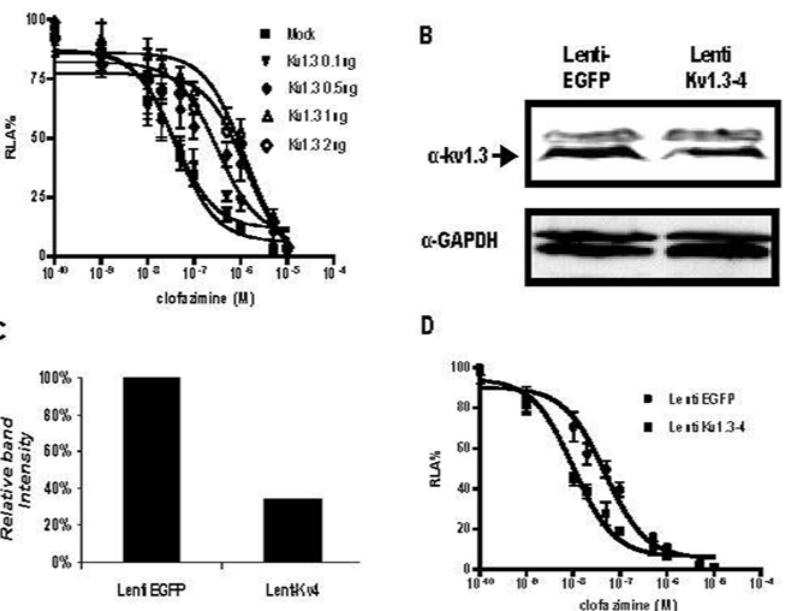
Figure 5. ( A ) Over-expression of Kv1.3 in Jurkat T cells resulted in resistance of the IL-2 luciferase reporter to CLF. The IC 50 s for different curves (Kv1.3 overexpression from low to high) are 41.6 6 8.4 nM, 41.0 6 14.5 nM, 386 6 214 nM, 1.37 6 0.52 m M and 1.46 6 0.63 m M (n=6). ( B ) Kv1.3 knockdown resulted in an increase in sensitivity of the IL-2 luciferase reporter to CLF. The IC 50 s for control EGFP-siRNA lentiviral transduced Jurkat T cells (control) was 49.9 6 13.0 nM, while that for shKv1.3-4 transduced cells was 10.5 6 2.4 nM (n=6). ( C ) Lentivirus-mediated knockdown of Kv1.3 assessed by Western blot. (D) Quantitation of Kv1.3 knockdown efficiency. After normalization against GAPDH, lenti-Kv1.3-4 decreased Kv1.3 protein level by 70% in comparison to the control